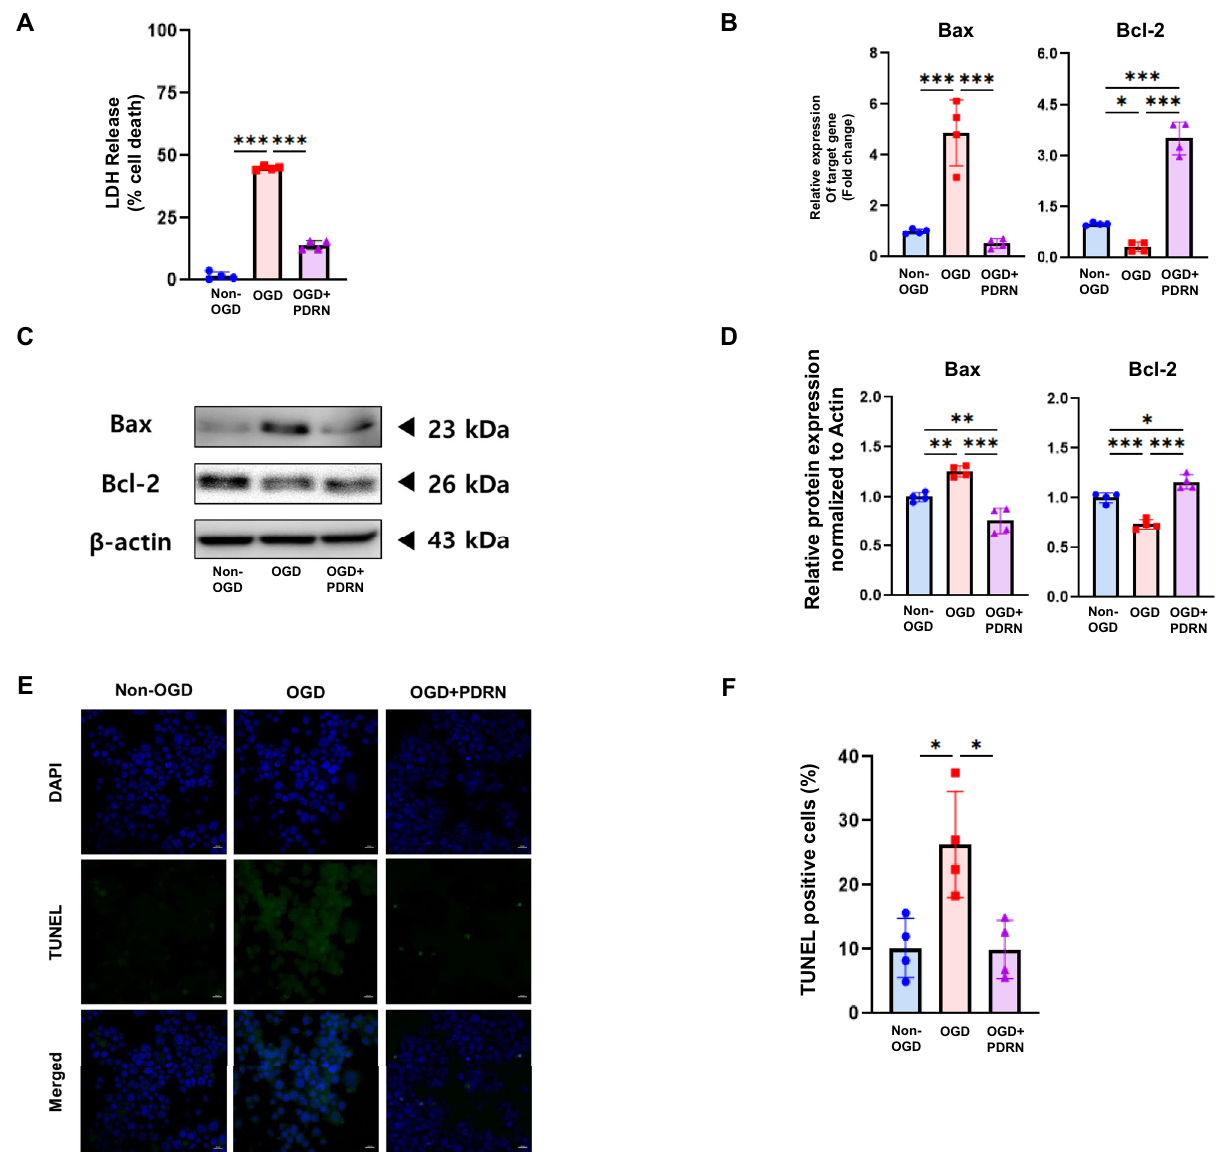
Figure 4. Effect of PDRN on apoptosis of in vitro I/R injury model. ( A ) The relative amount of released LDH detected by LDH assay ( B ) The relative gene expression of Bax and Bcl-2 detected by RT-qPCR ( C ) Western blotting analysis of Bax and Bcl-2 in Non-OGD, OGD, and OGD + PDRN groups ( D ) Quantification of western blotting signals of Bax and Bcl-2 ( E ) TUNEL assay in Non-OGD, OGD, and OGD + PDRN groups ( F ) Quantification of TUNEL assay. Values are presented as means ± SEM. Scale bars = 100 µm. Statistically significant differences are shown as * p < 0.05, ** p < 0.01, *** p <